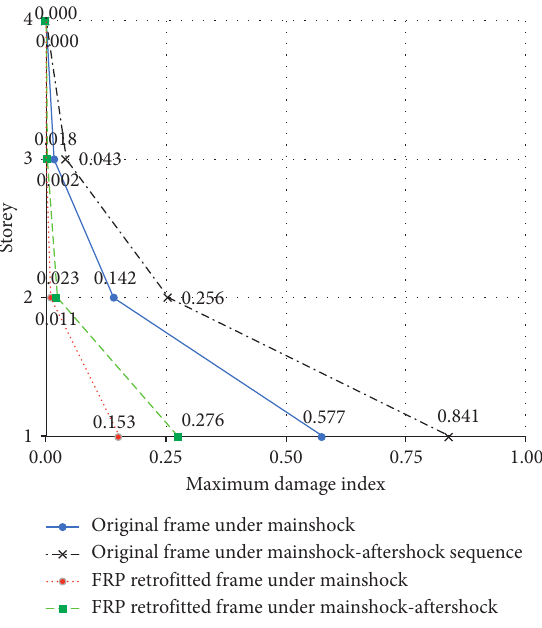
Figure 10: Maximum damage indices of storeys.